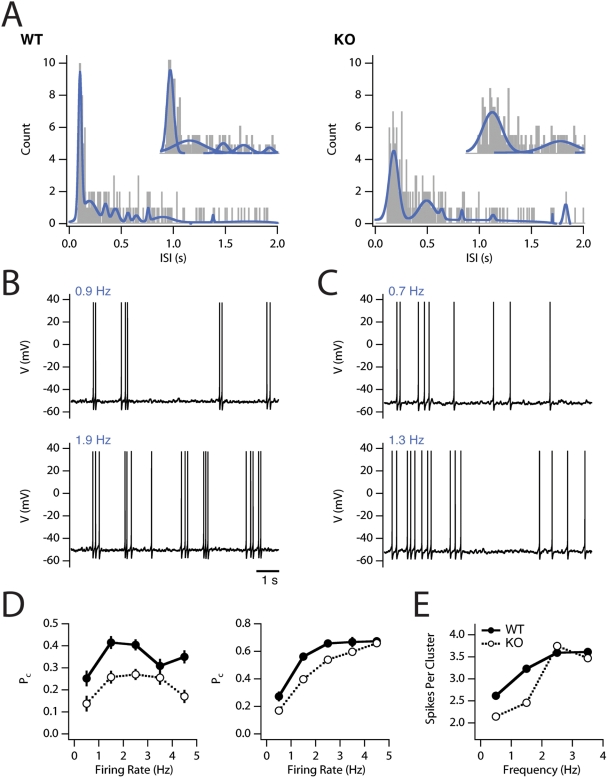
Clustered spiking in the stochastic model.(A) Examples of interspike interval histograms calculated from long
duration simulations (150 s) of the response of the wild-type (WT; left)
and knock-out (KO; right) models to DC current injection. In both
examples the mean firing rate is in the 1–2 Hz range. ISI
distributions were fit with multiple Gaussians (solid blue lines).
Insets show individual peak fits for the 0–0.6 s interval of
the histogram. (B–C) Examples of 10 s duration epochs of
membrane potential activity from simulations with the wild-type (B) and
knockout (C) models. Average firing rate for the trial is stated in
blue. (D) Pc is plotted as a function of average firing rate
for the wild-type (closed symbols) and knockout (open symbols) models
using the ‘stringent’ clustering definition (left
panel) and the ‘relaxed’ clustering definition
(right panel). Several hundred, 16 s duration simulations of the
partially stochastic model (Figure S6) were used to provide
detailed sampling. (E) Number of spikes per cluster is plotted for a
subset of the data.